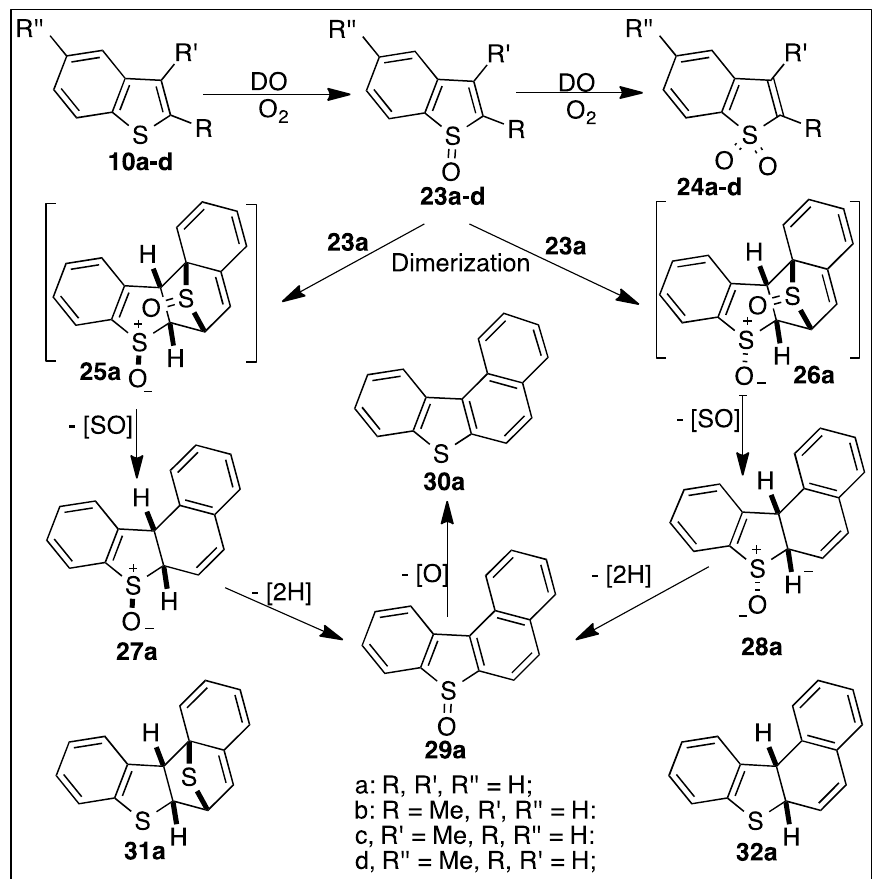
cis -dihydrodiols 4 R ,5 S - 11b (>98% ee ) and 4 R ,5 S - 11c (>98% ee ), but the presence of a methyl group at the C-5 position inhibited cis -dihydroxylation at the 4,5-bond of substrate 10d (Table